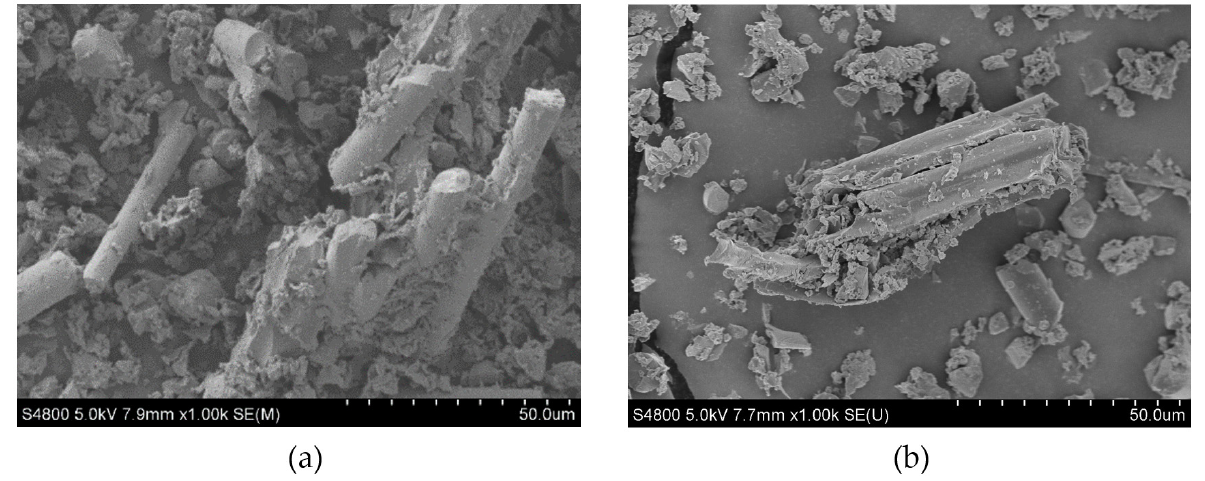
Figure 1. SEM image of nonmetallic printed circuit board (NMPCB) powder: ( a ) untreated and ( b ) treated. ( b )